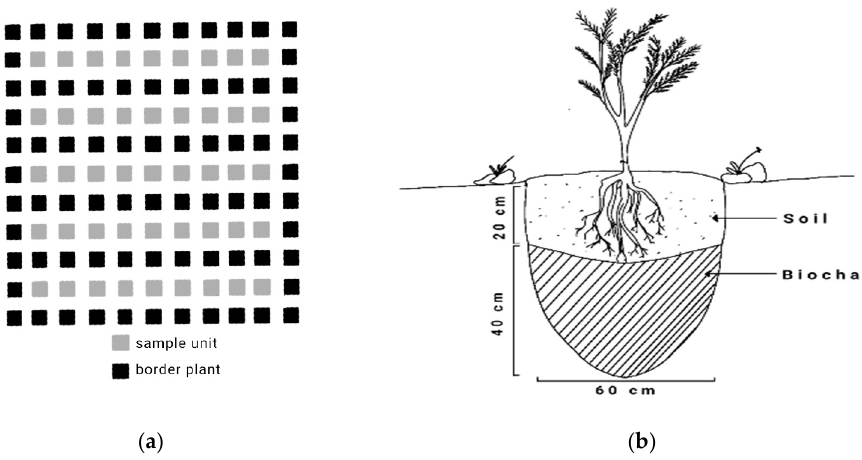
Figure 2. ( a ) The plantation site design, and ( b ) application of biochar and soil in planting holes.